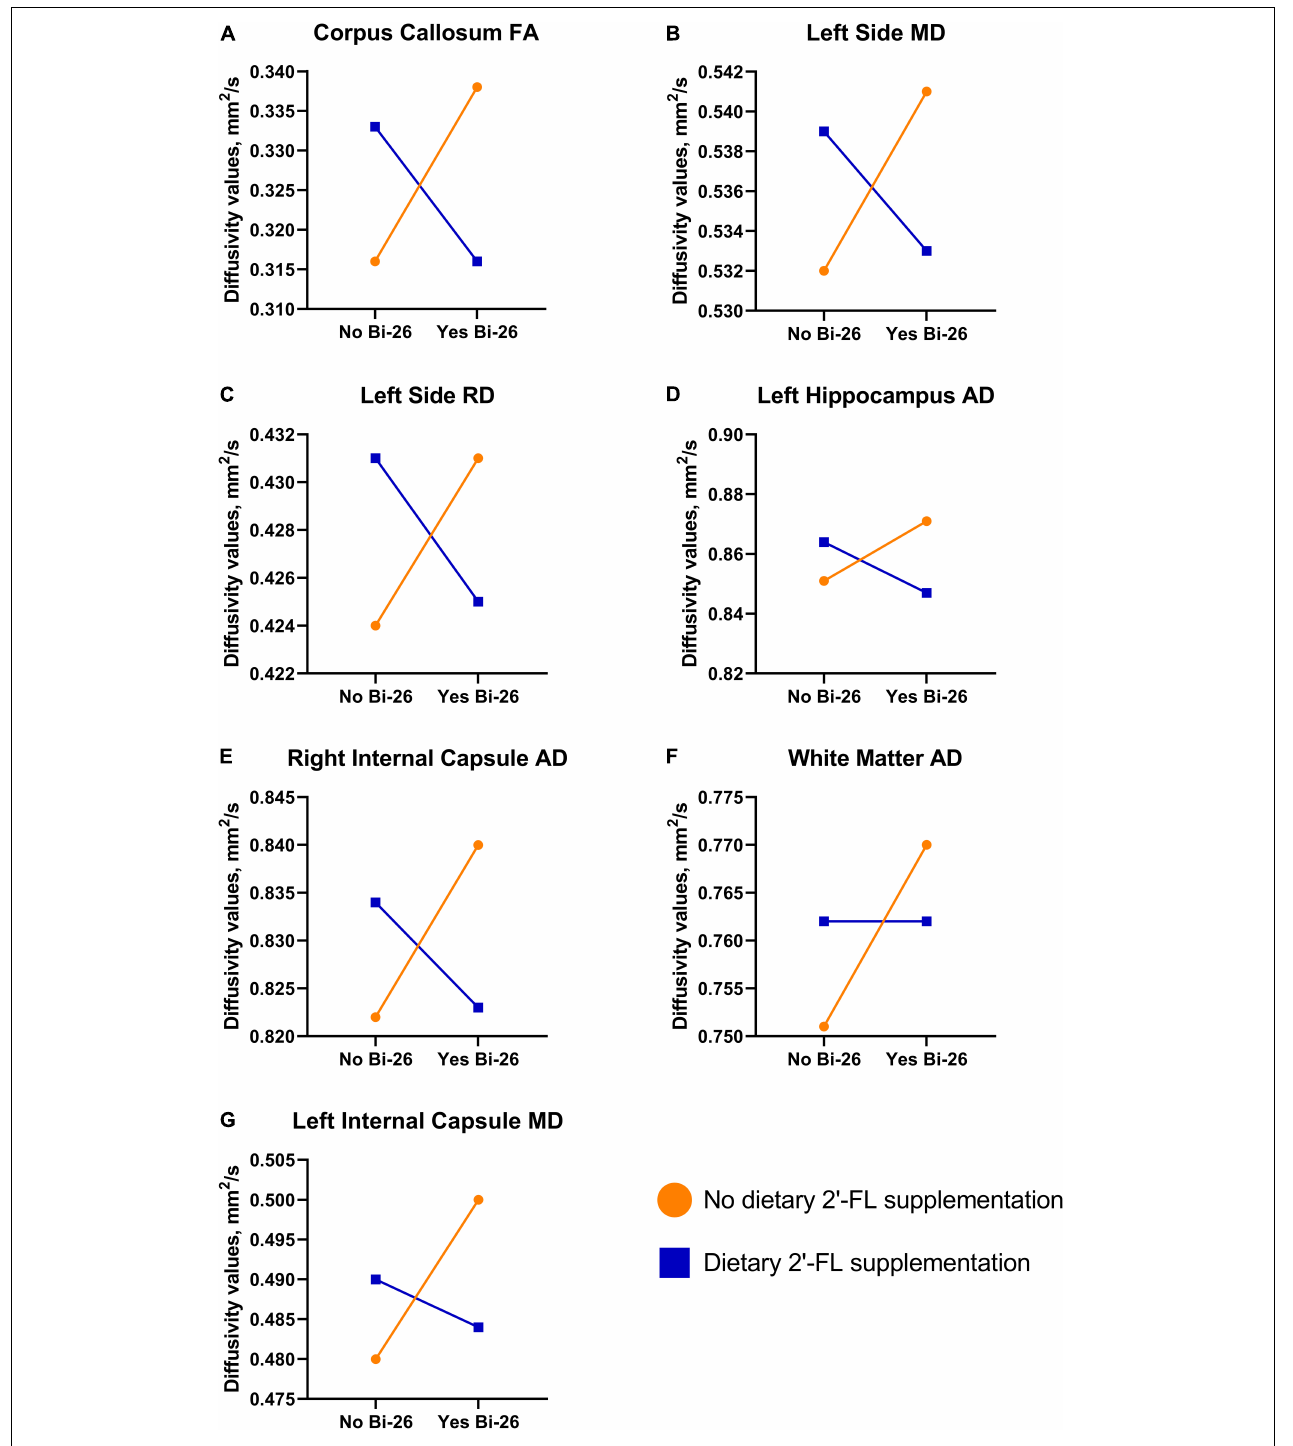
FIGURE 2 | Diffusion tensor imaging interaction results. Various interactive effects were observed between the different treatment groups. (A–E) A similar trend was observed for FA in the corpus callosum ( P = 0.030), MD and RD in the left side of the brain ( P < 0.019), AD in the left hippocampus ( P = 0.025), and AD in the right internal capsule ( P = 0.042). For these regions supplementation with 2 (cid:48) -FL and Bi-26 separately increased values, but these effects were negated when the test articles were supplemented in tandem. (F,G) For AD in overall white matter ( P = 0.039) and MD in the left internal capsule ( P = 0.006), a pair-wise comparison indicated that Bi-26 supplementation alone led to increased values. AD, axial diffusivity; Bi-26, Bifidobacterium longum subsp. infantis-26 ; FA, fractional anisotropy; MD, mean diffusivity; RD, relative diffusivity; 2 (cid:48) -FL, 2 (cid:48) -fucosyllactose.